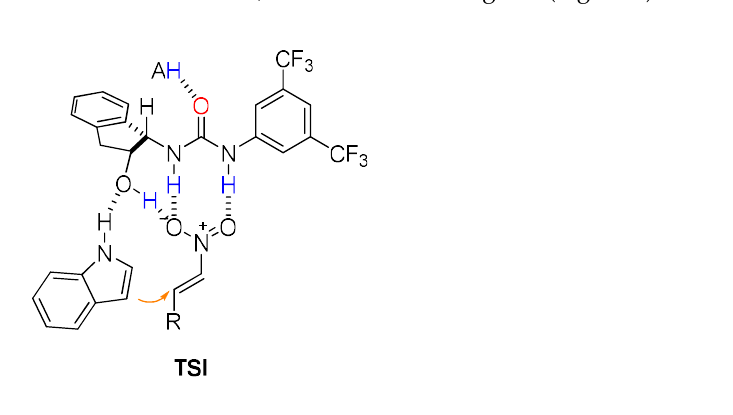
Figure 7. Proposed transition states for the [urea acid]-catalyzed Friedel-Crafts reaction.